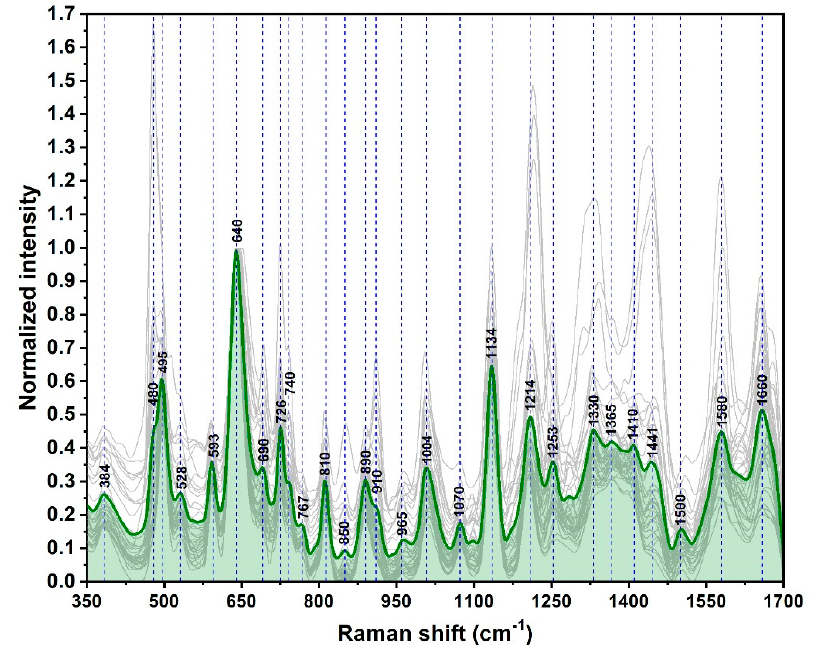
Figure 4. Surface Enhanced Raman (SER) spectra of blood plasma samples obtained from healthy donors ( n = 35) recorded on the solid silver plasmonic substrates (SSPSs) using a 785 nm excitation laser. The mean spectrum is highlighted in green. The spectra were normalized to the 640 cm − 1 peak.